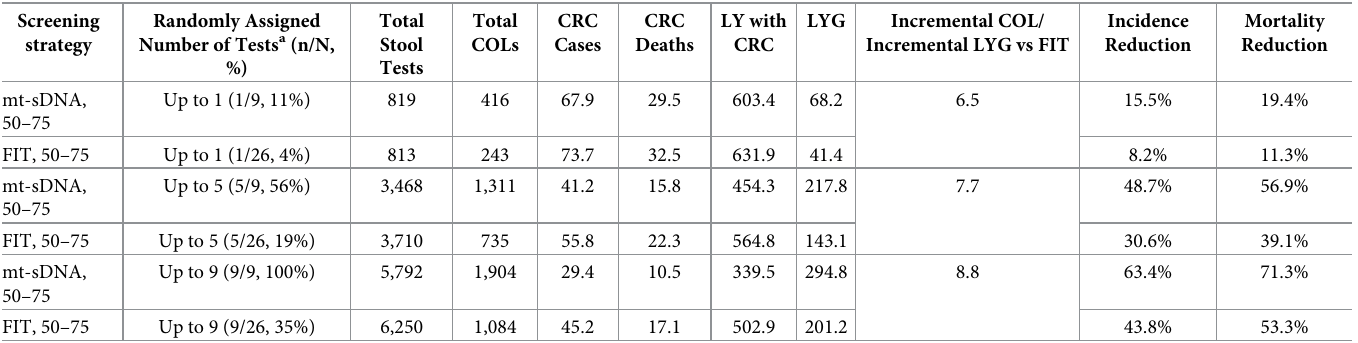
Table 3. Predicted outcomes per 1000 individuals screened from ages 50–75 compared with no screening. Screening